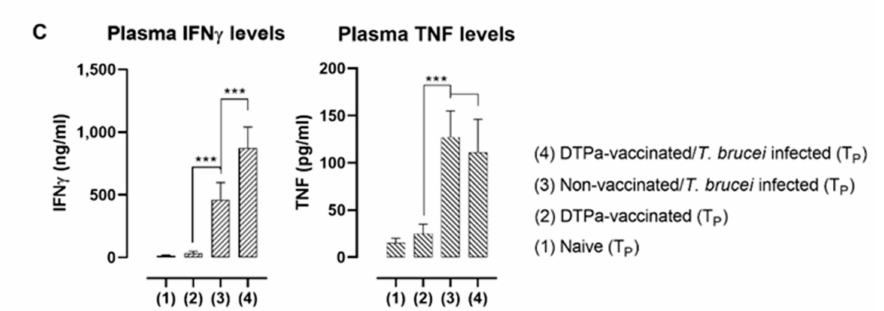
Figure 5. DTPa vaccination results in the temporary improvement of T. b. brucei